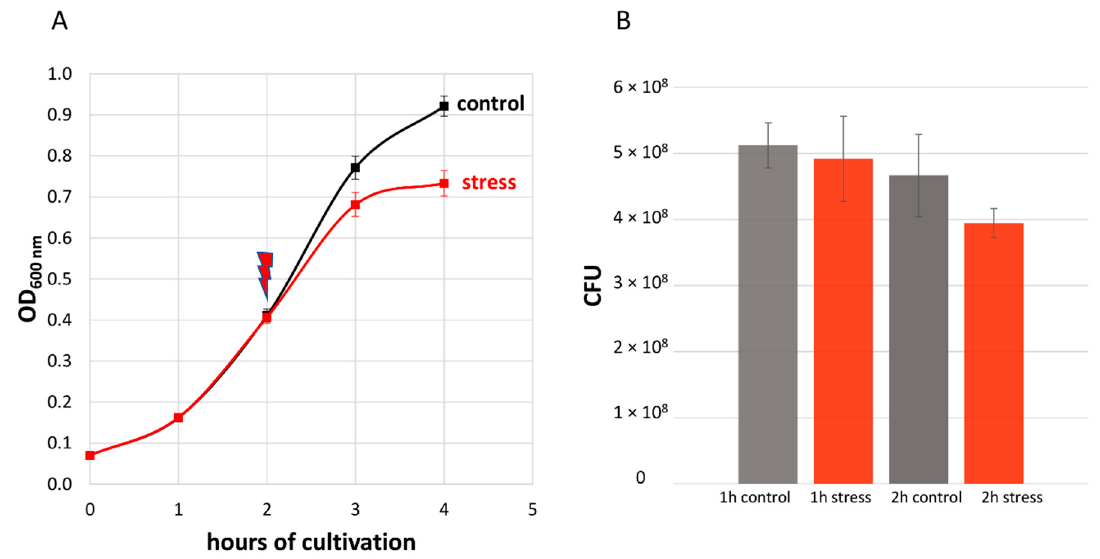
Figure 2. ( A ) Effect of 2.5 µg/mL LL-37 on the growth of S. pneumoniae D39. The red arrow indicates the application of the stress after two hours of cultivation. Error bars represent the standard deviation. n = 6. ( B ) Colony-forming units (CFU) per ml OD 600 = 1 bacterial suspension. Samples were taken every hour after the addition of 2.5 µg/mL LL-37. Means are shown and error bars represent the standard deviation. n = 3.